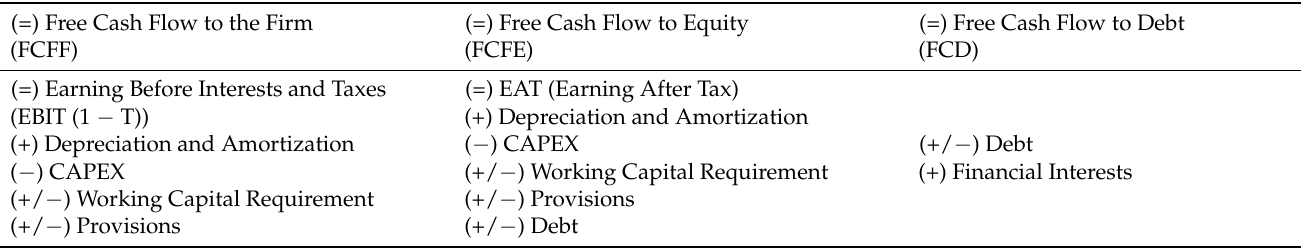
Table 2. Method of determining free cash flow